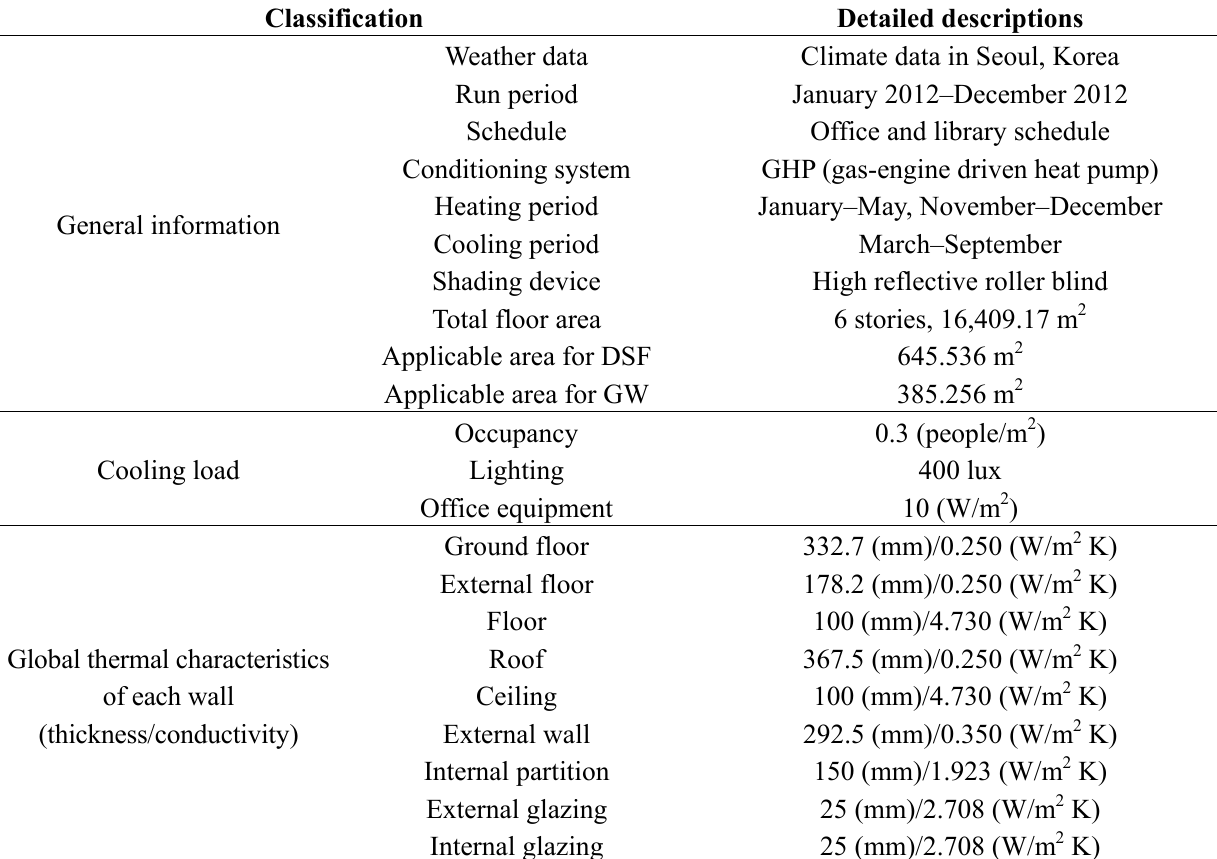
Table 4. Simulation model information of the basic energy model.